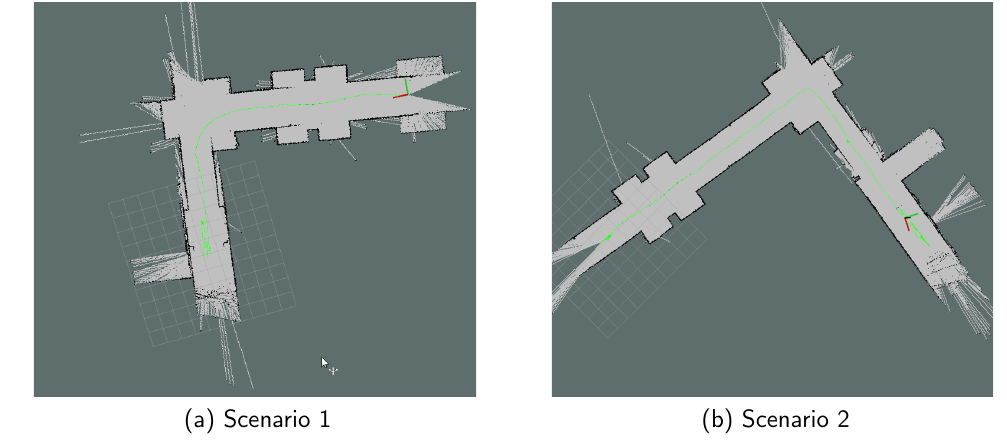
Figure 13. 2D mapping results of two indoor corridor scenarios.